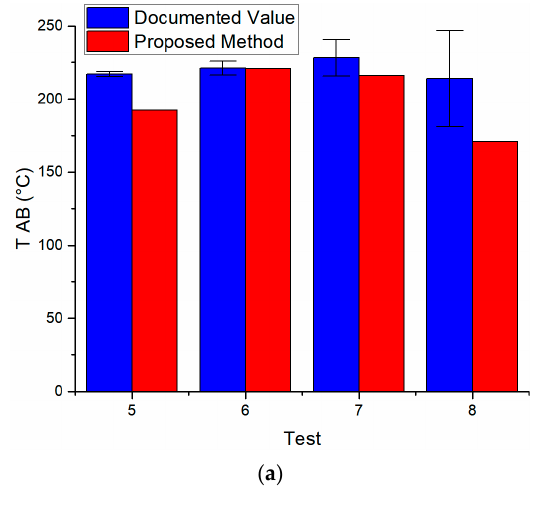
Figure 6. Temperature predictions for machining AISI 1045 steel. The average temperatures in the primary shear zone are shown in ( a ); The average temperatures in the secondary shear zone are shown in ( b ). The documented values are predicted values adopted from the literature [42]. As shown in Figure 6, the predicted temperatures in the PSZ were larger than their corresponding documented values because the documented values were calculated using a heat partition equation ( (cid:1846) (cid:3002)(cid:3003) = (cid:1846) (cid:3045) + (cid:2015)Δ(cid:1846) (cid:3020)(cid:3027) ), in which the heat partition ratio ( (cid:2015) ) was taken as 1, based on the best performance of the predictions [40]. This assumption gave acceptable prediction accuracy, as shown in Table A1, but it was not true in real cutting tests. On the other hand, the proposed method did not need this assumption for the temperature prediction. The other heat partition ratio ( (cid:2032),(cid:1846) (cid:3036)(cid:3041)(cid:3047) = (cid:1846) (cid:3045) + ∆(cid:1846) (cid:3020)(cid:3027) + (cid:2032)∆(cid:1846) (cid:3014) ), used in calculating the temperature in the SSZ, was taken as 0.75, based on Xiong’s study [43]. This value was reported for their successful temperature prediction in the SSZ. The predicted temperatures in the SSZ were in good agreement with the documented